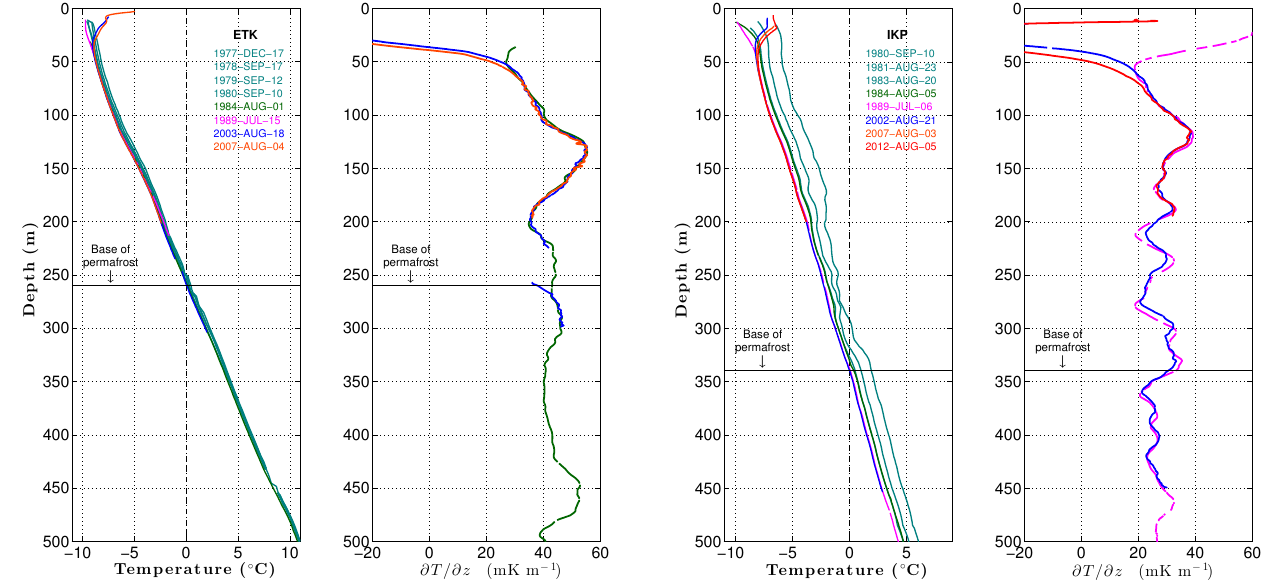
Earth Syst. Sci. Data